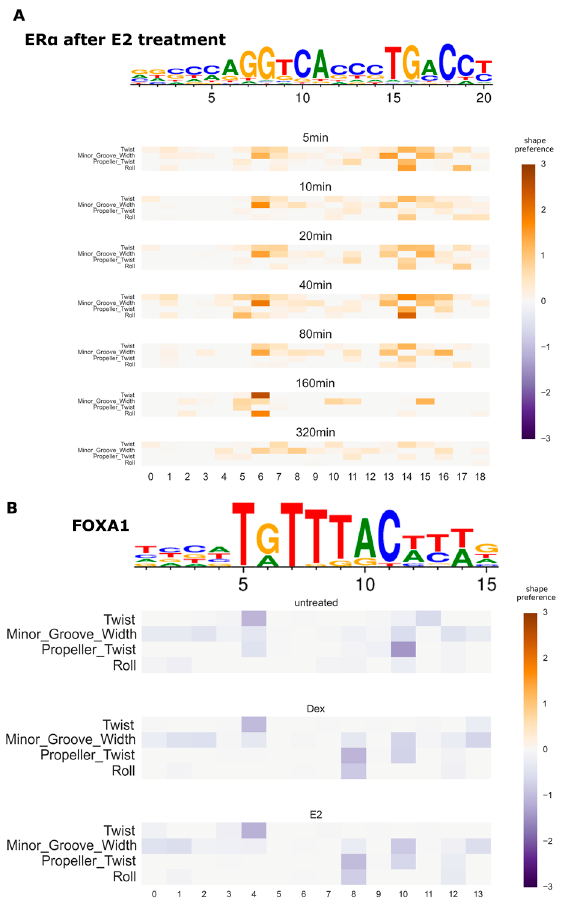
Figure 5. Condition-specific DNA shape preferences in protein-DNA interaction. ( A ) Variation of inferred shape preferences of ER α at different time points after the treatment with estradiol (E2) in the MCF7 cell line; ( B ) Variation of inferred shape preferences of FOXA1 after the treatment with either dexamethasone (Dex) or E2 in the MCF7 cell line. The heatmaps show the preference for each shape feature at each position (the inferred d f matrix). Only the positive preferences are shown in ( A ), and only the negative preferences are shown in ( B ). Colors faded to grey mean weaker preference. The PWM logos are shown above the shape preference heatmaps.